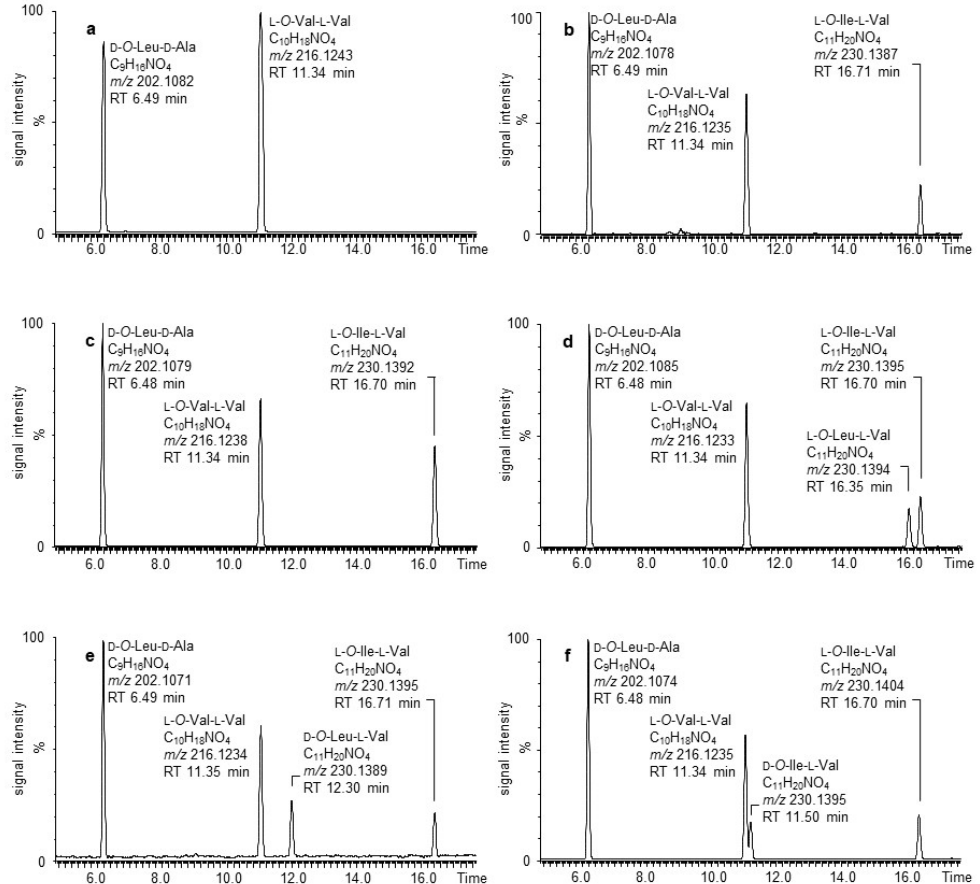
Figure 3. UPLC-ESI – -TOF-MS-analyses of alkaline hydrolysates of ( a ) cereulide ( 1 ), ( b ) isocereulide A ( 2 ), ( c ) 2 spiked with L - O -Ile- L -Val, ( d ) 2 spiked with L - O -Leu- L -Val, ( e ) 2 spiked with D - O -Leu- L -Val, and ( f ) 2 spiked with D - O -Ile- L -Val.